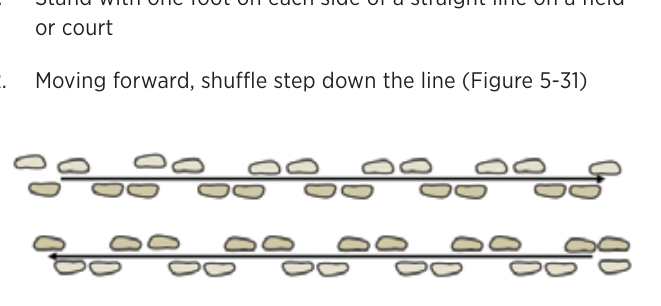
Figure 5-31. Line Jump Routine – Scissors